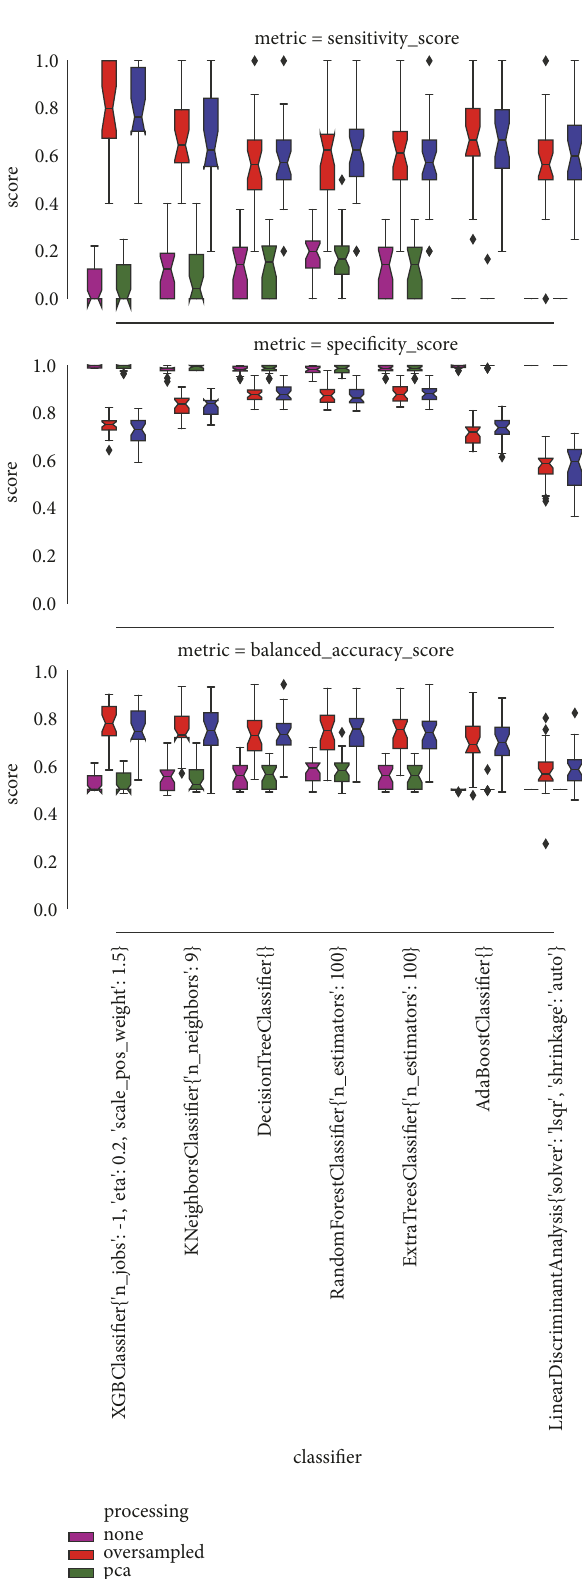
Figure 7: Results of sensitivity, specificity, and balanced-accuracy